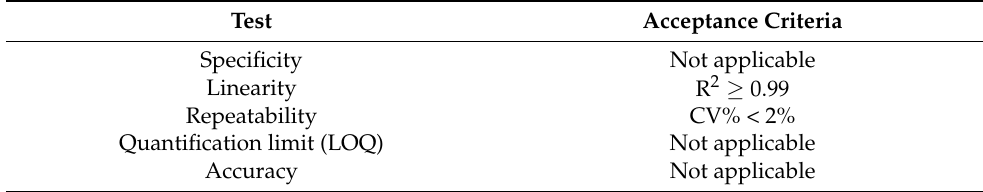
Table 2. Tests and acceptance criteria in determining radiochemical purity using UV-Radio-HPLC.